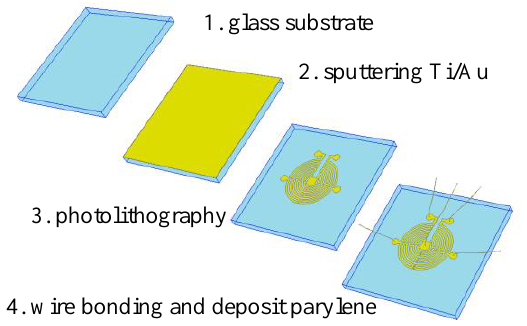
Figure 5. Diagram of the fabrication process of the sensor